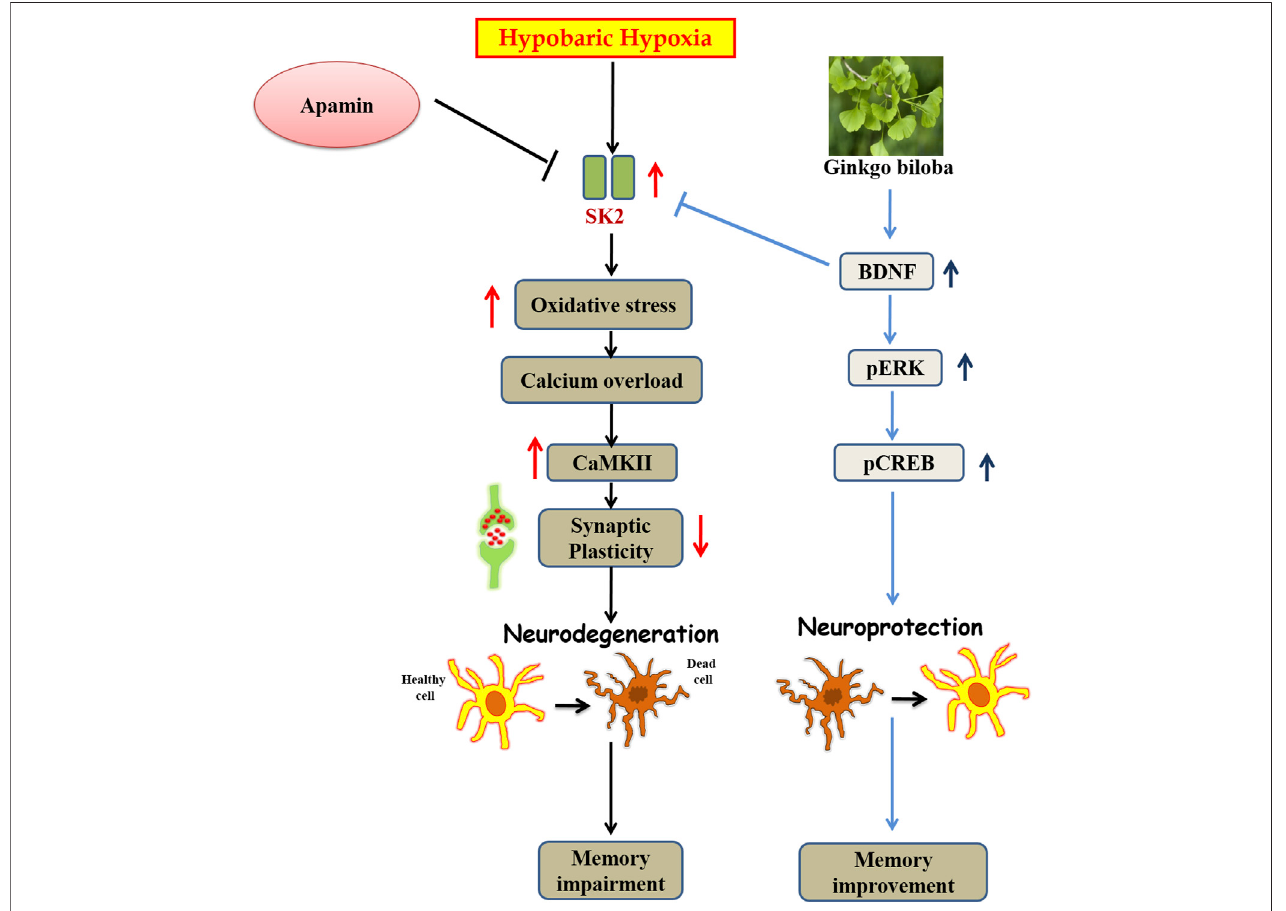
FIGURE 9 | Graphical representation of abstract: Schematic diagram representing the mechanism of action of Ginkgo biloba L. during HH.